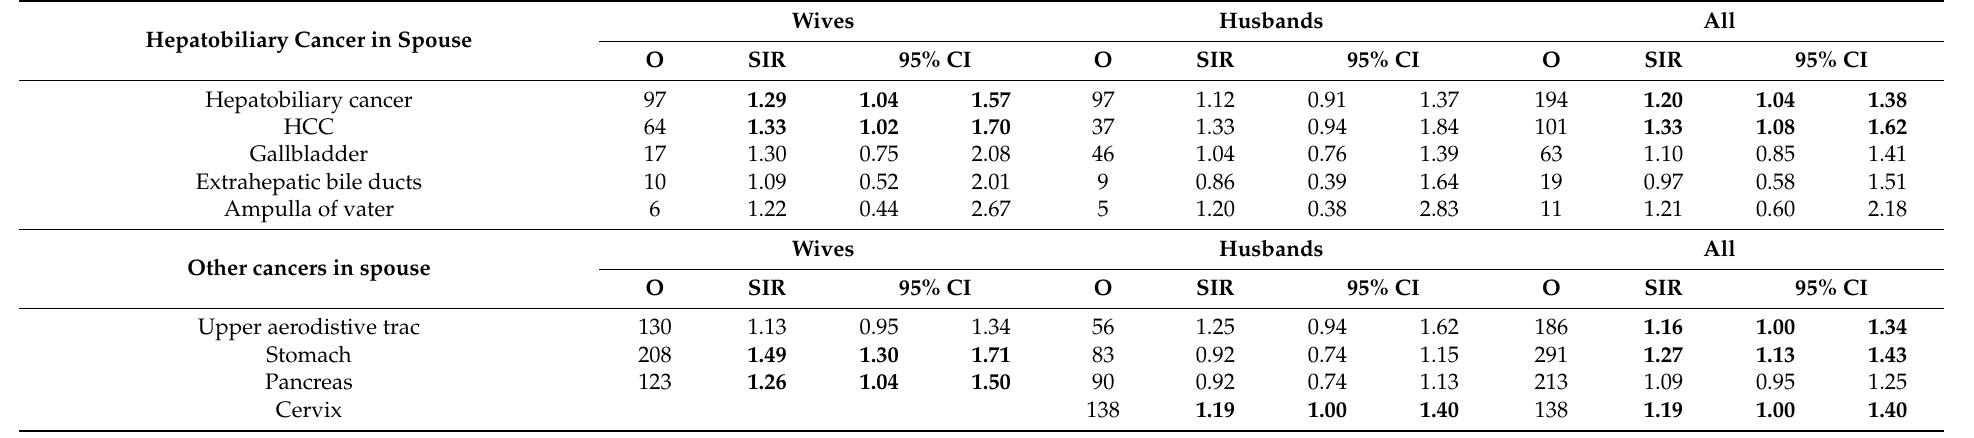
Table 5. Risks of hepatobiliary cancer among spouses.